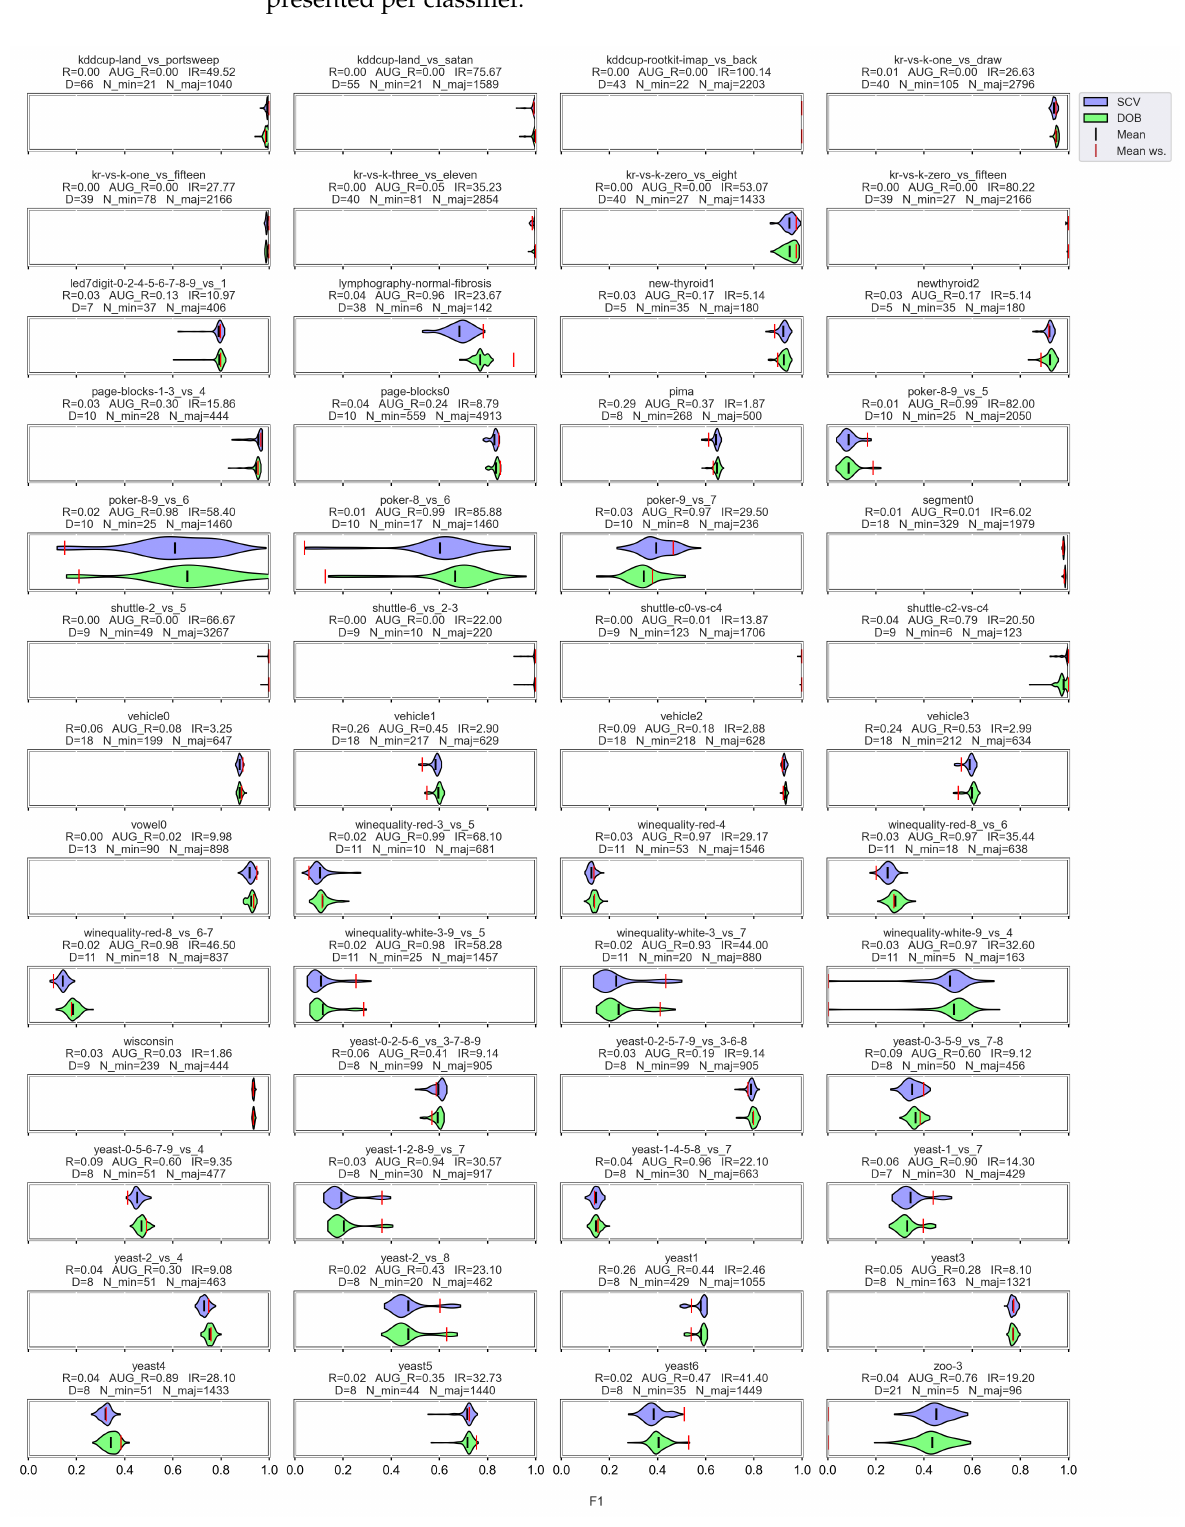
Figure A1. F 1 values resulted by DTree classifier and named oversamplers per data set of